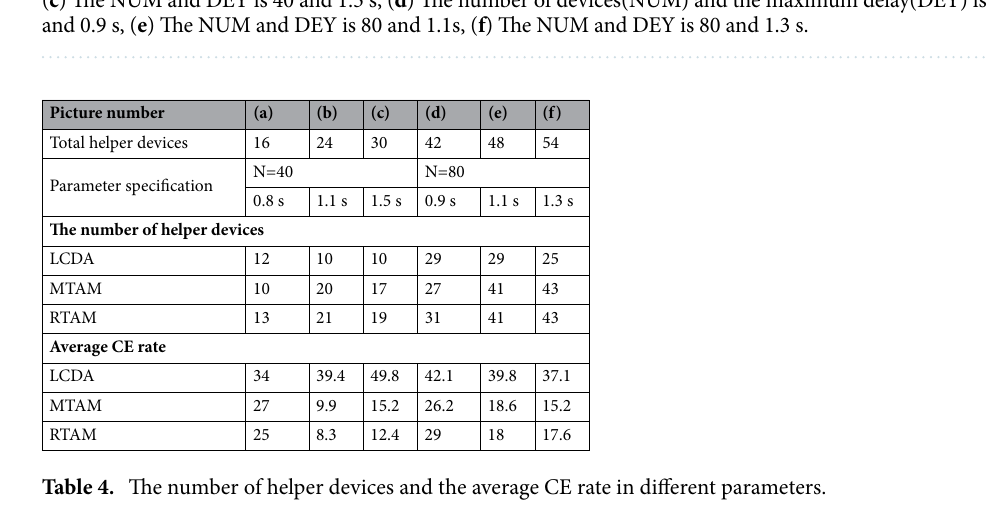
Figure 8. Computing efficiency versus the number of local computing devices of different kinds: ( a ) The number of devices(NUM) and the maximum delay(DEY) is 40 and 0.8s, ( b ) The NUM and DEY is 40 and 1.1s, ( c ) The NUM and DEY is 40 and 1.5 s, ( d ) The number of devices(NUM) and the maximum delay(DEY) is 80 and 0.9 s, ( e ) The NUM and DEY is 80 and 1.1s, ( f ) The NUM and DEY is 80 and 1.3 s.